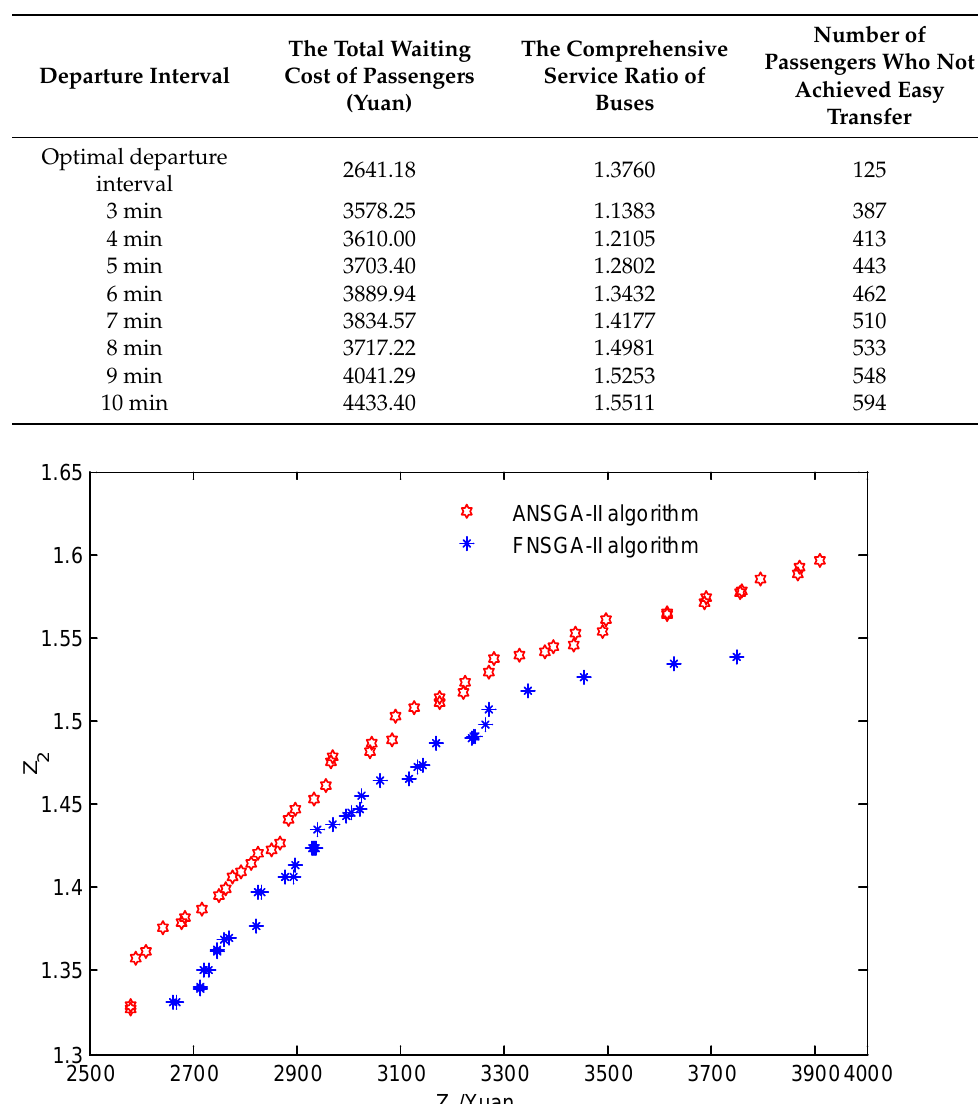
Table 6. Comparison and analysis of schedules.